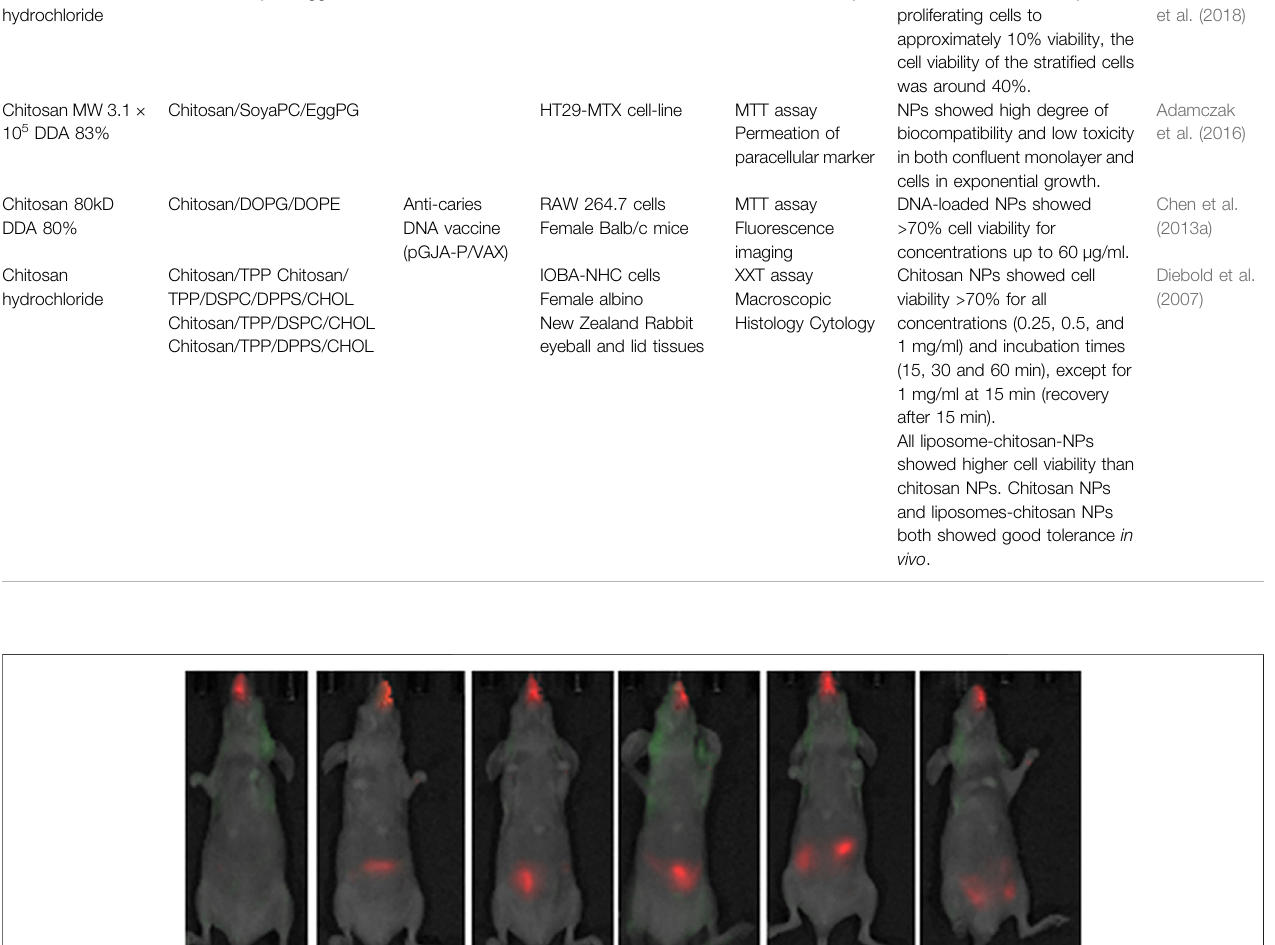
Frontiers in Pharmacology |